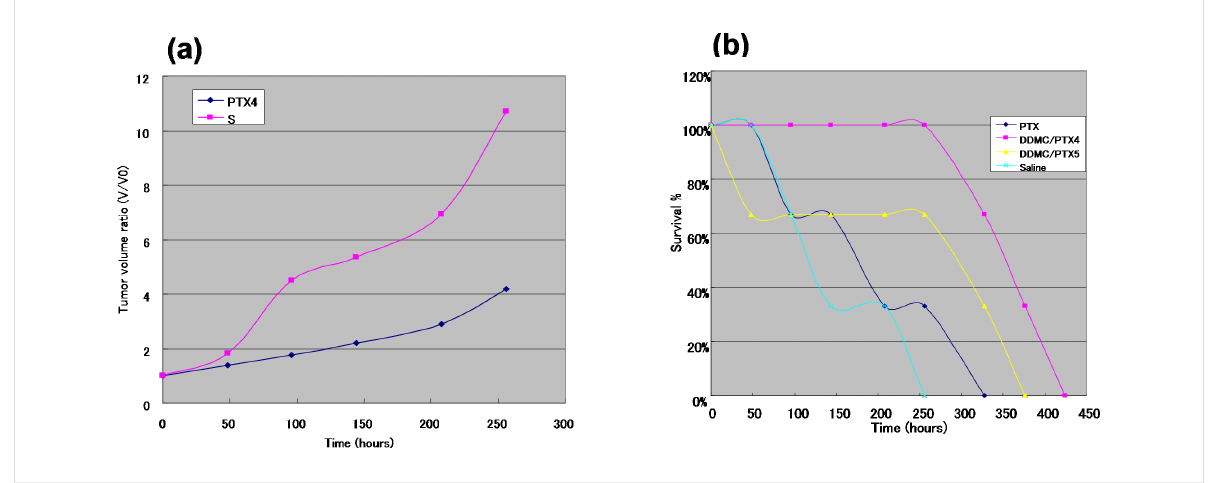
Figure 7: In vivo analysis of the anticancer activity and survival rates of the DDMC/PTX complex in B16F10 melanoma cells. (a) The increase rate ( V / V 0 ) of mean tumor volumes in the saline and DDMC/PTX4 (particle size: 50 nm) ( p < 0.09). (b) The relationships between survival rate and time (hours) with the PTX, saline, DDMC/PTX4 (particle size: 50 nm) and DDMC/PTX5 (particle size: 290 nm) groups. (b): Reprinted from [62].